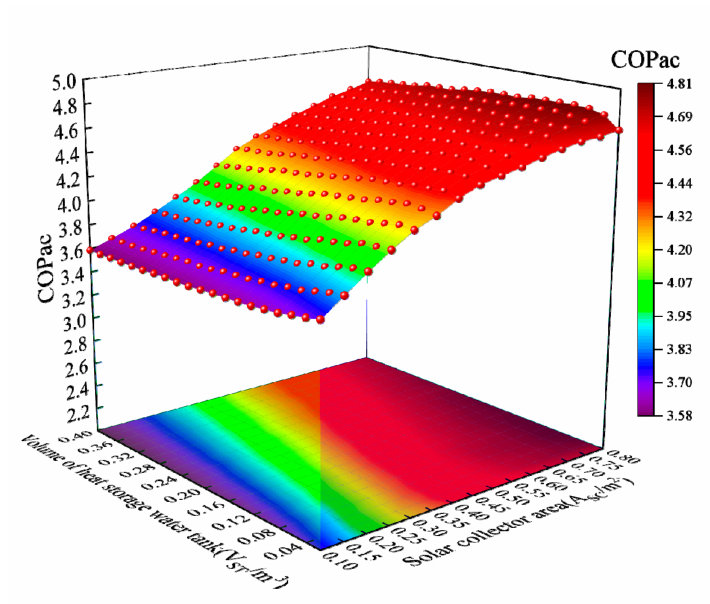
Figure 11. Diagram of COP ac changes as A SC and V ST change.